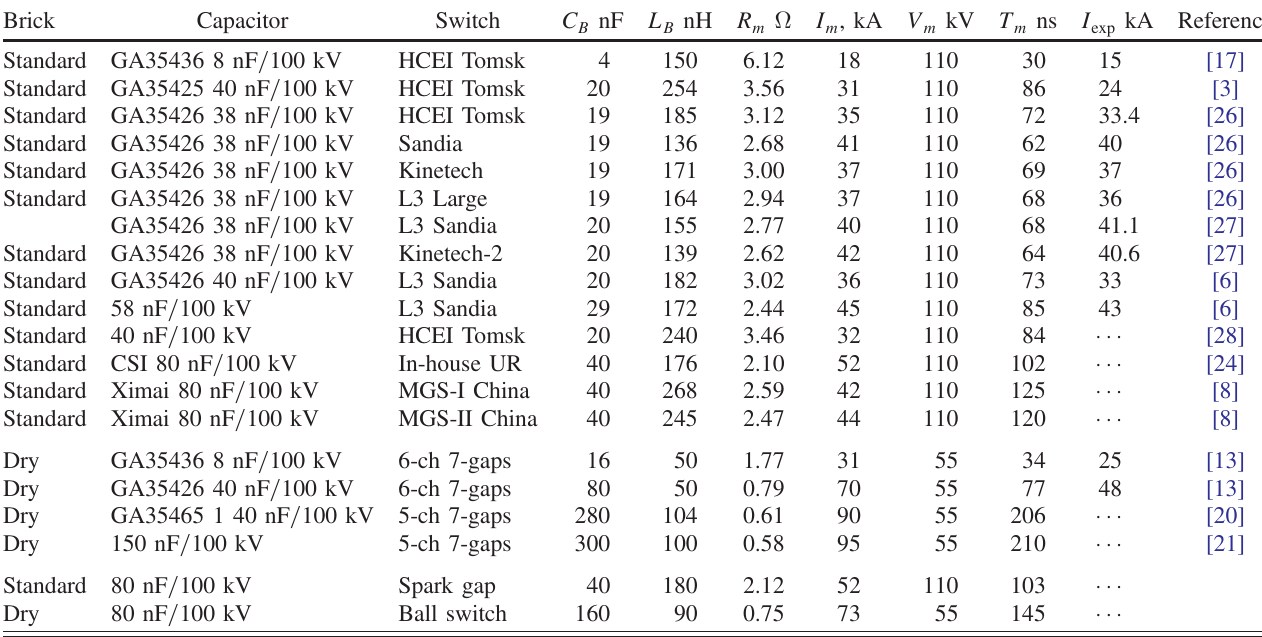
TABLE I. The matched load circuit parameters for standard and dry bricks.